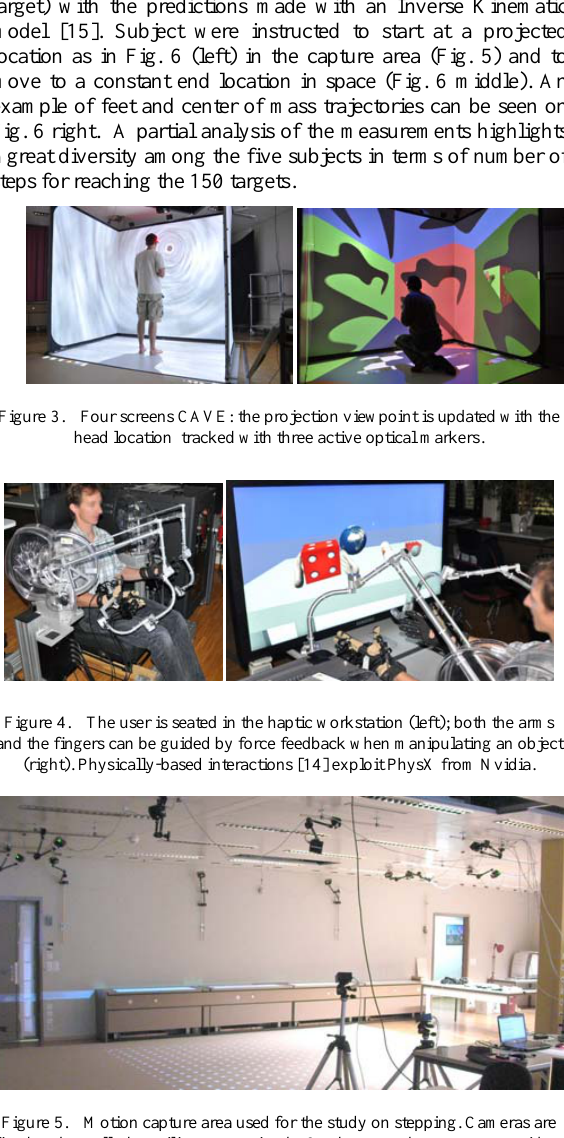
Figure 5. Motion capture area used for the study on stepping. Cameras are fixed to the wall, the ceiling or on tripods. On the ground one can see a video- projected calibrated pattern to guarantee the correct display of targets [15].